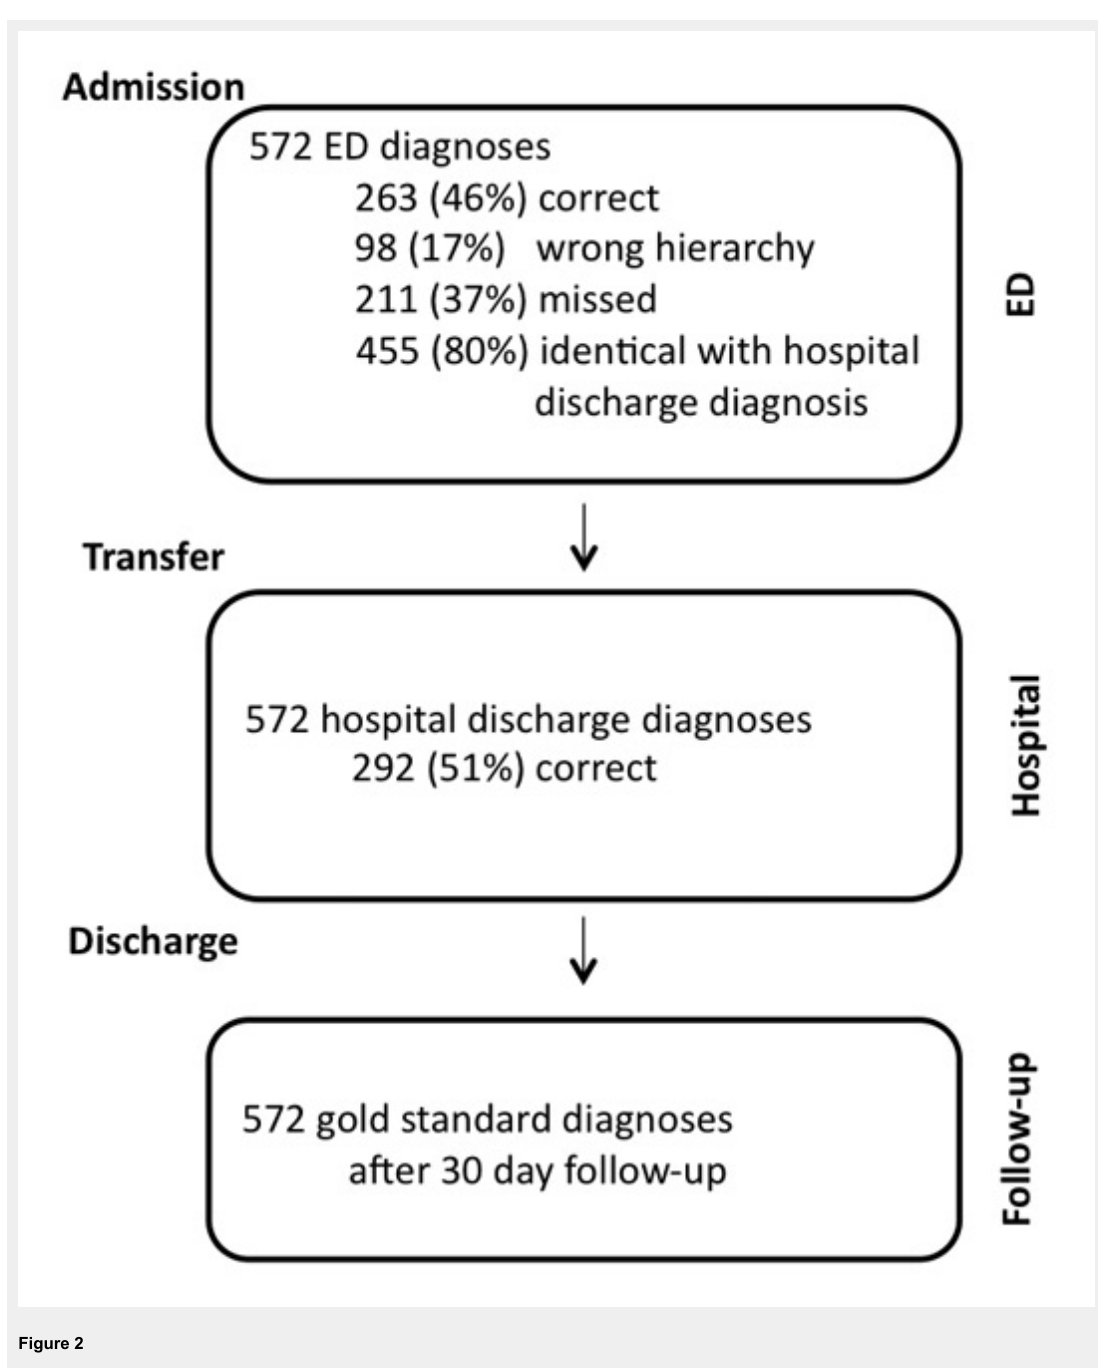
Figure 2 Overview of the proportions of correct diagnoses . Gold standard diagnosis: Final diagnosis, according to rules of the 10th International Classification of Diseases and Related Health Problems (ICD-10), made independently by two physicians as described above. ED diagnoses (primary, i.e. first listed): The ED diagnoses that were made by the emergency physicians at the end of the stay in the ED. Hospital (i.e. Basel University Hospital) discharge diagnoses (primary, i.e. first listed): Diagnoses from the hospital discharge letters. If the patient was not hospitalised, the hospital discharge diagnosis was identical with the ED diagnosis. Correct diagnosis: Primary ED diagnosis or hospital discharge diagnosis is identical with gold standard diagnosis. Wrong hierarchy: The gold standard diagnosis was listed as a secondary ED diagnosis, but not as the primary ED diagnosis. Missed diagnosis: The gold standard diagnosis was not made at the